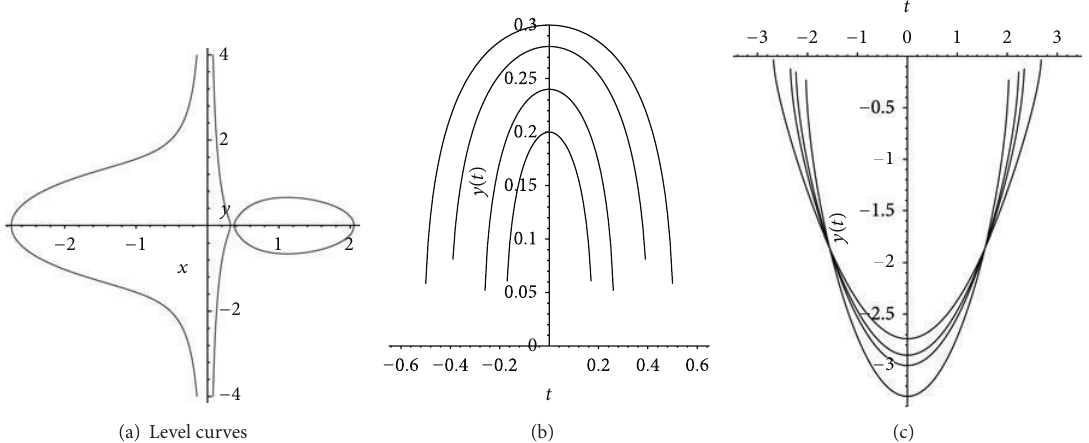
Figure 13: The level curves and profiles of breaking wave solutions of